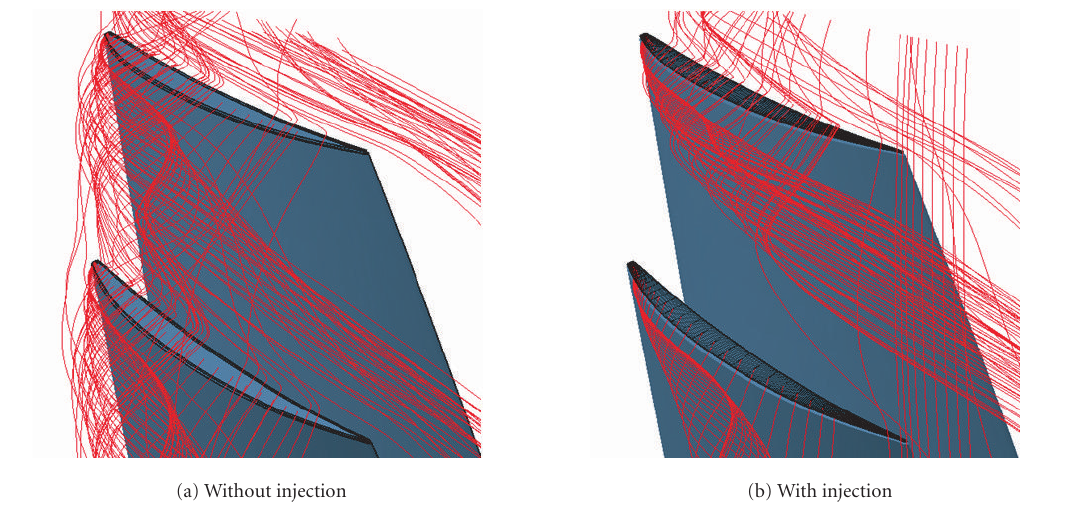
Figure 13: Computed tip-clearance vortex particle traces at smoothwall stall mass flow